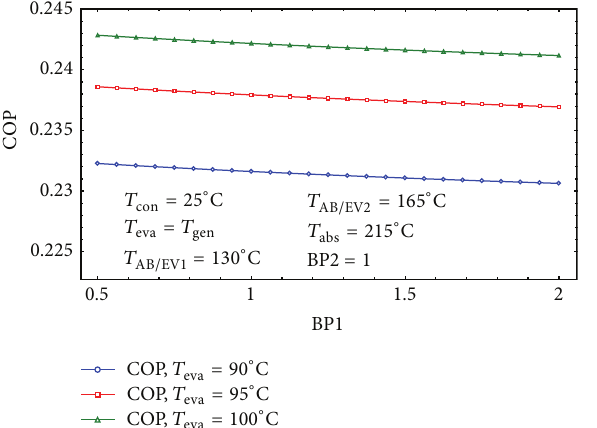
Figure7:TheeffectofBP2ontheCOPofthecycleforthreedifferent 𝑇 . eva